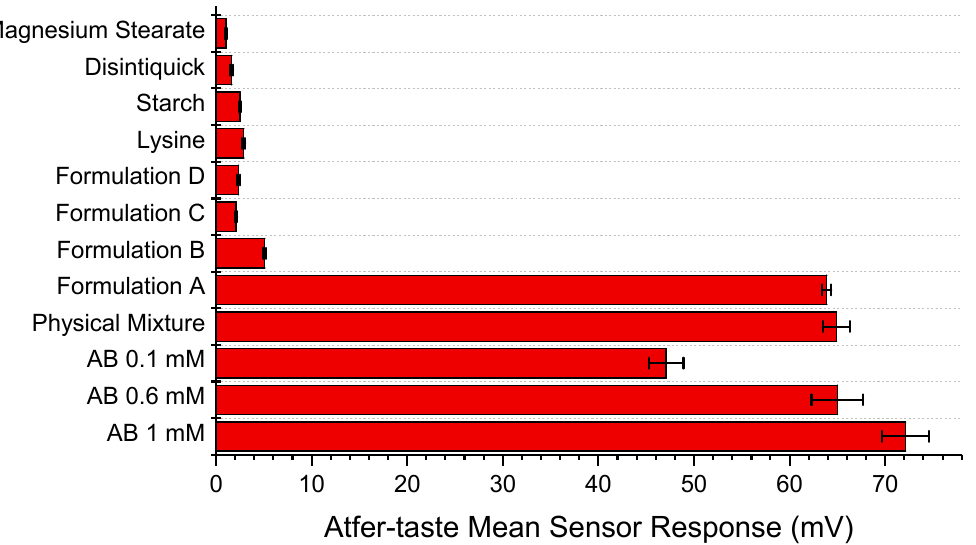
Figure 5. A chart comparing the aftertaste or CPA measurements (AC0 sensor) of the various excipients, the physical mixture without l -lysine and the formulated AB mini-tablets, as measured by the AC0 sensor.